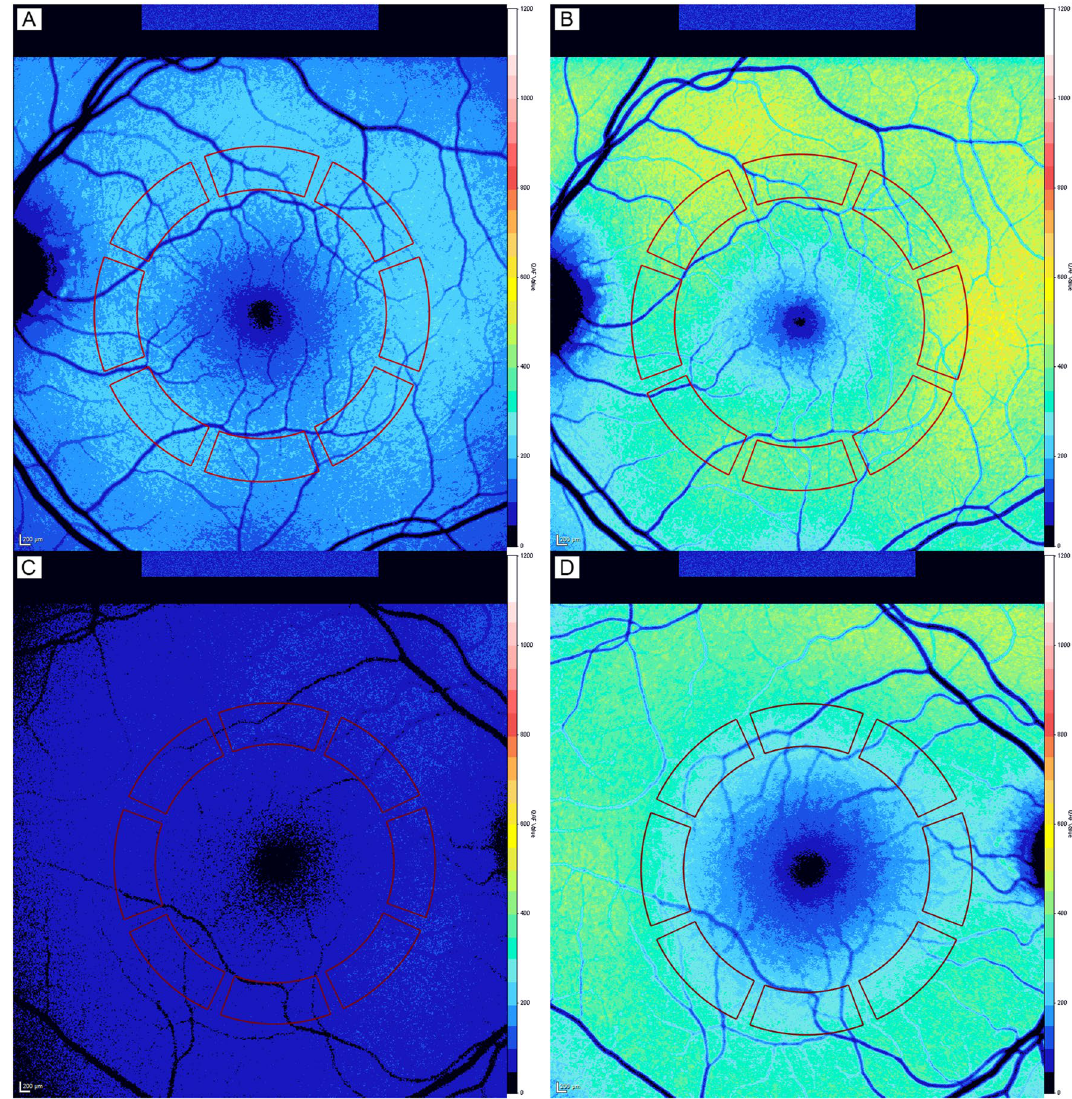
of the Delori-pattern (red pattern). The top row shows the left eye with a LOCS III grading of (NO = 2/ NC = 2/C = 1/P = 1) and the bottom row shows the right eye of the same patient with a LOCS III grading of (NO = 3/NC = 3/C = 2/P = 3). Images were acquired and analyzed with the Heidelberg Eye Explorer (HEYEX) Version 1.9.10.0 (Heidelberg Engineering, Heidelberg,